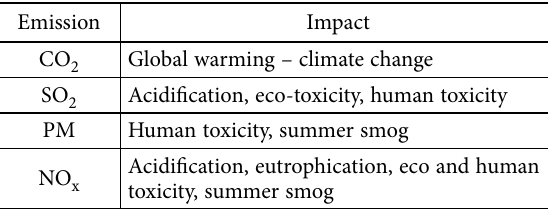
Table 2. Impact of exhaust emissions